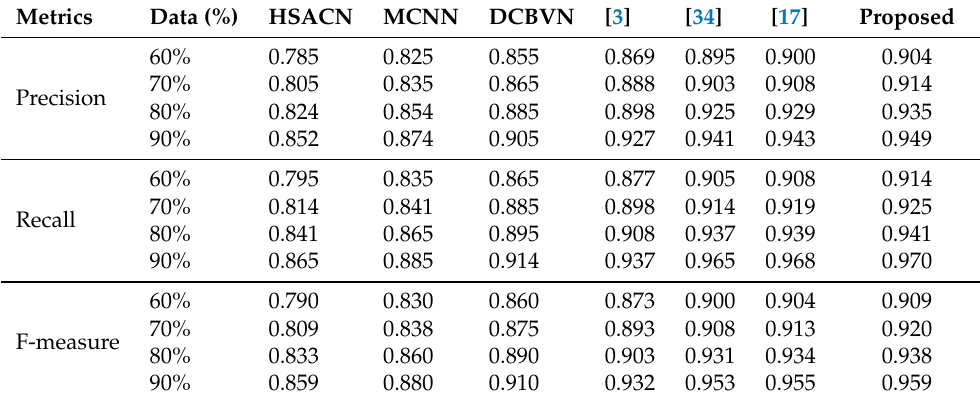
Table 1. Comparative analysis of Sentiment Classification for IMDB dataset in terms of precision, recall and